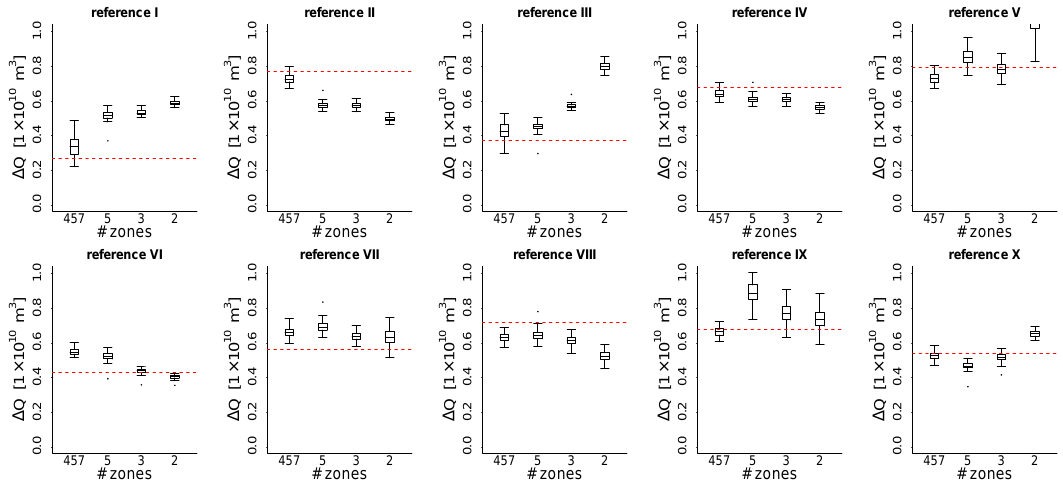
Fig. 16. Total amount of water exchanged between river and aquifer over the second half of the simulation period (day 300 to day 609) for conditional simulations with EnKF (scenario D). Red lines mark the water exchange for the different reference